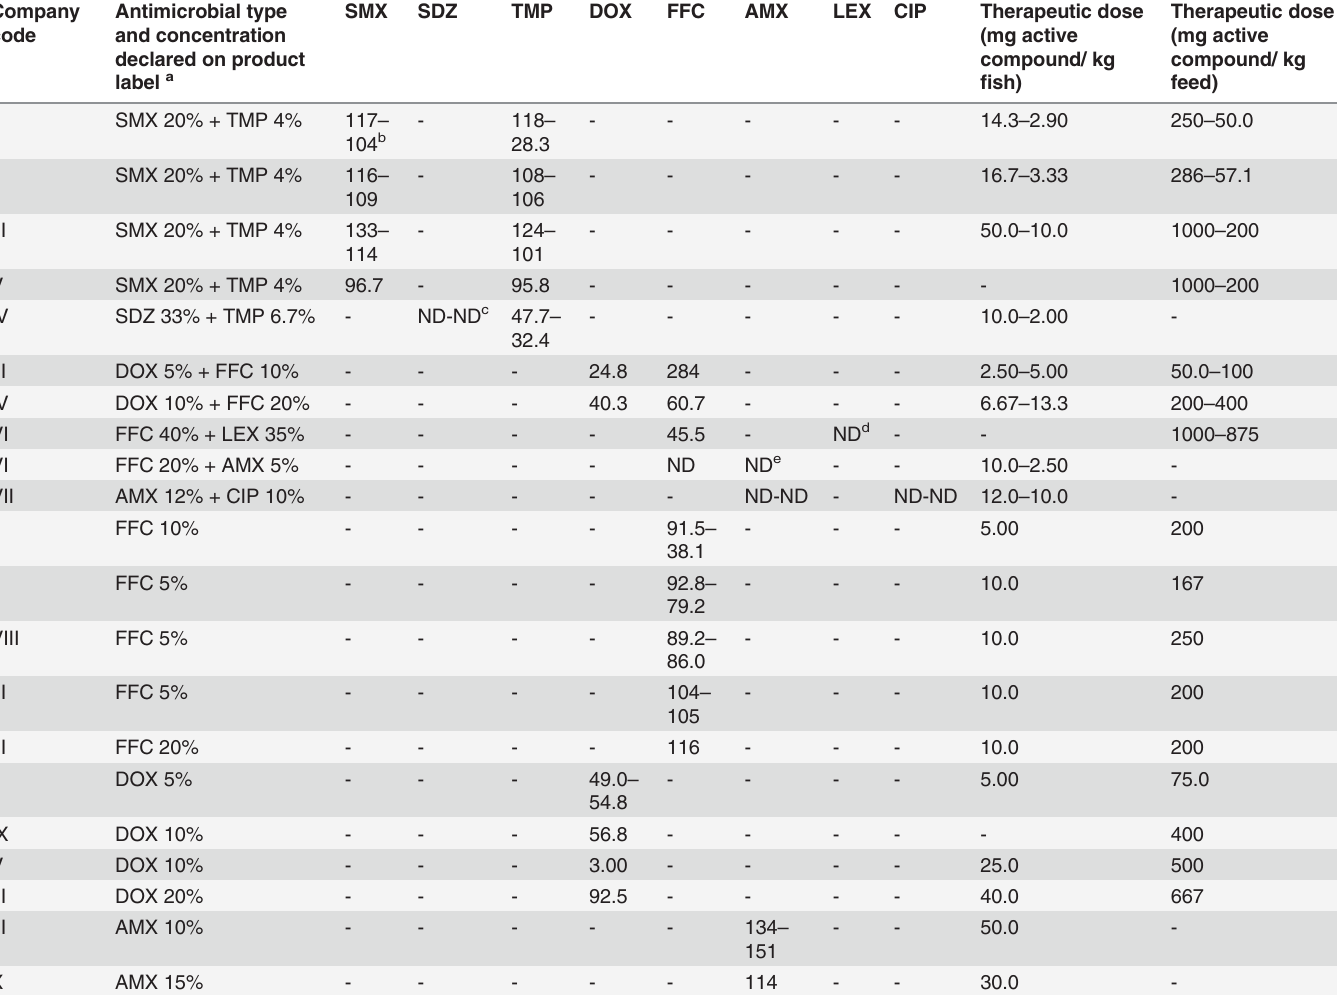
Table 2. Active antimicrobial compound concentration as compared with the concentration declared on product labels (%) and therapeutic dose declared. Company Antimicrobial type code and